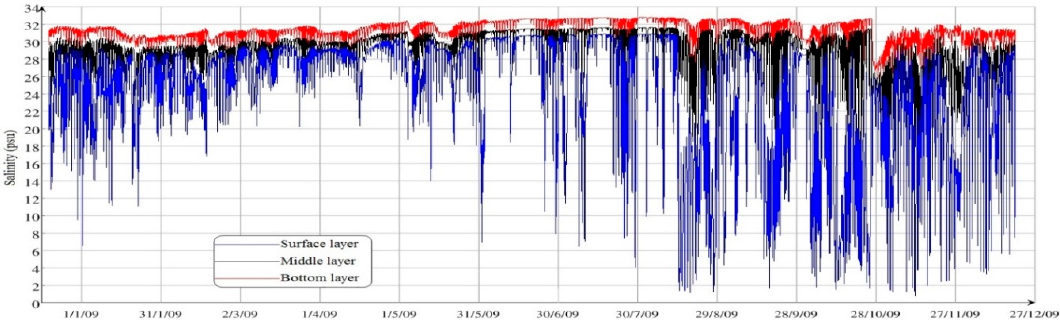
Figure 17. Time series of the distribution of salinity (psu) at station T1.